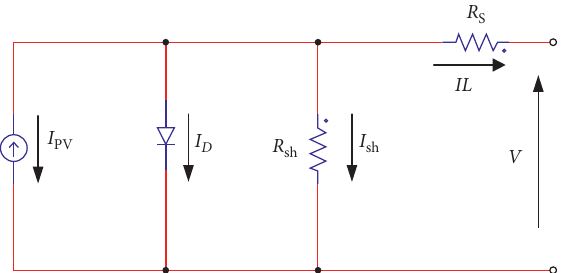
Figure 2: Equivalent solar cell circuit.